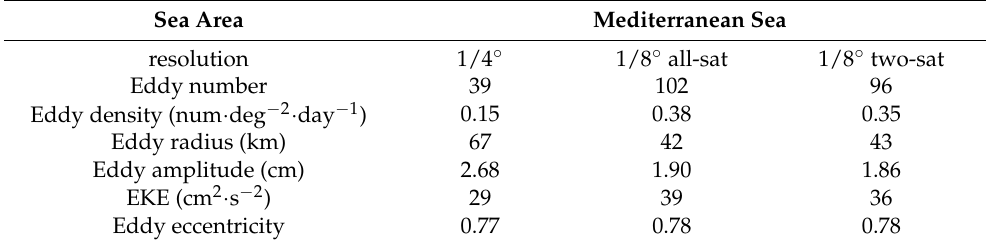
Table 3. Parameters describing the identified eddies in the Mediterranean